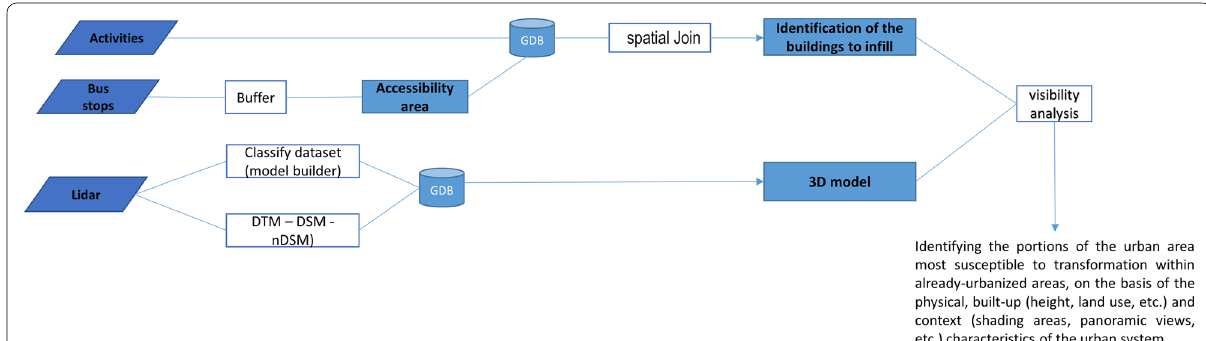
Fig. 1 The procedural GIS steps of the methodology proposed. The parallelograms are the inputs, the white rectangles are the spatial analysis and the blue rectangles are the